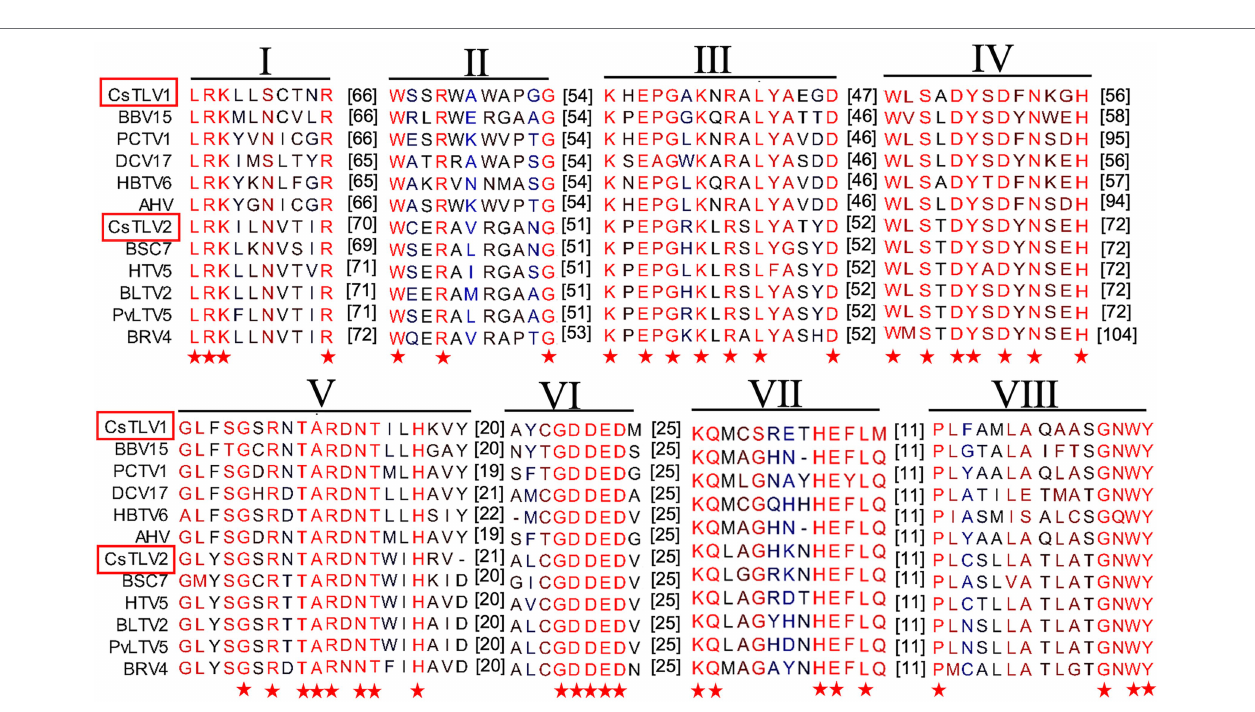
FIGURE 3 | Schematic representation of CsTLV1 and CsTLV2 genome. The two overlapping open reading frames (ORFs) and the untranslated regions (UTRs) are shown by boxes and a single line, respectively. Nucleotide positions of ORFs and the putative slippery site for − 1 frameshifting, spacer and pseudoknot are indicated too. EFE (kcal/mol) indicates the minimal free energy.